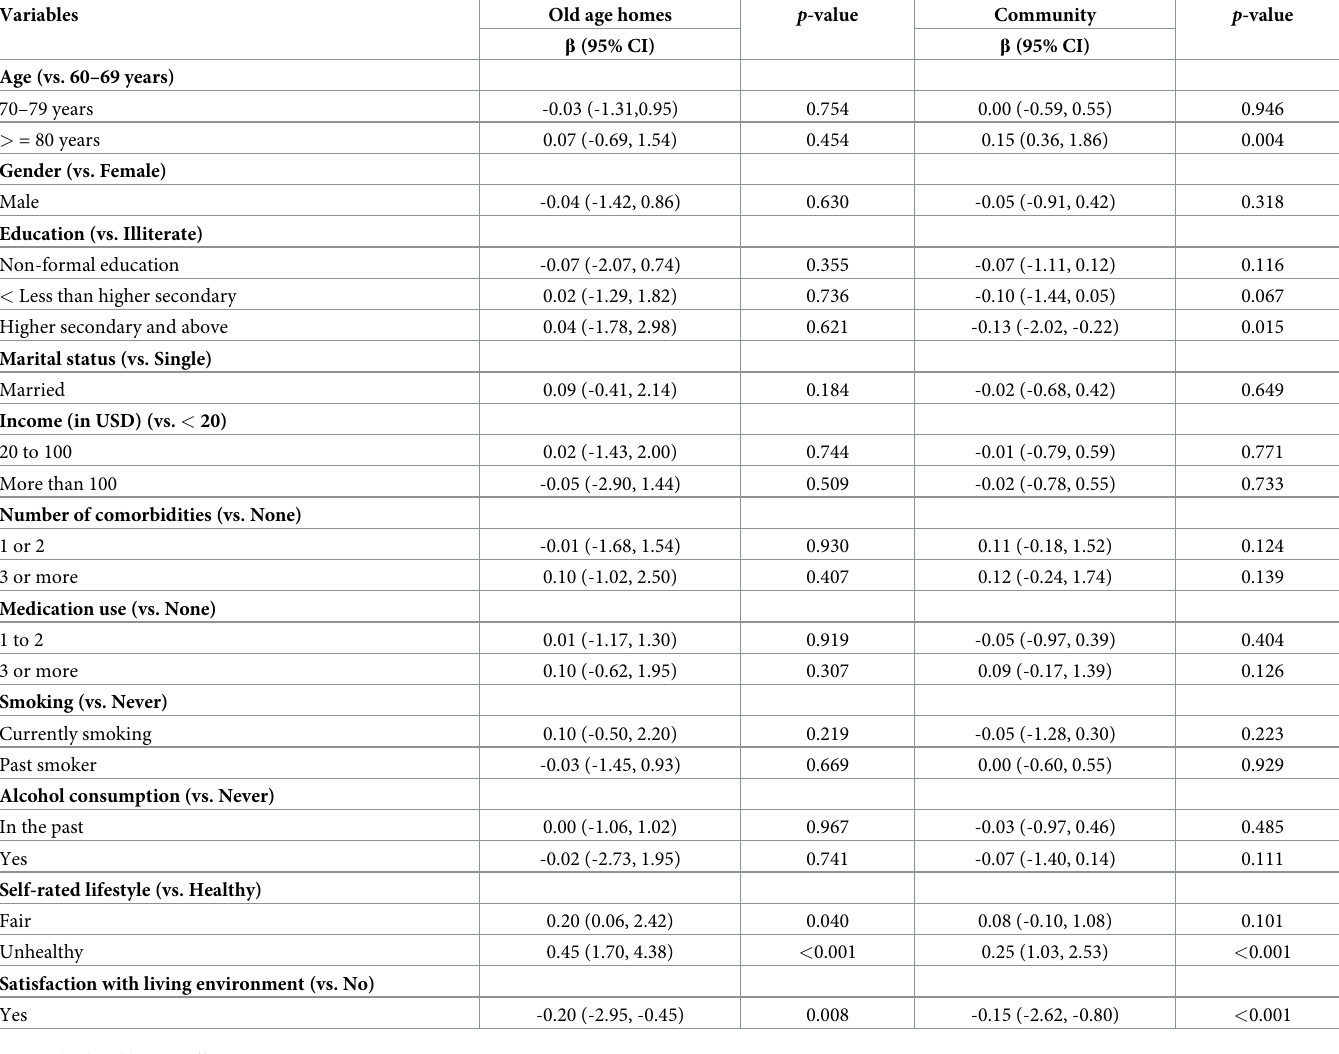
Table 3. Multiple linear regression: Factors associated with overall GFI in old age homes (n = 193) and the community (n =